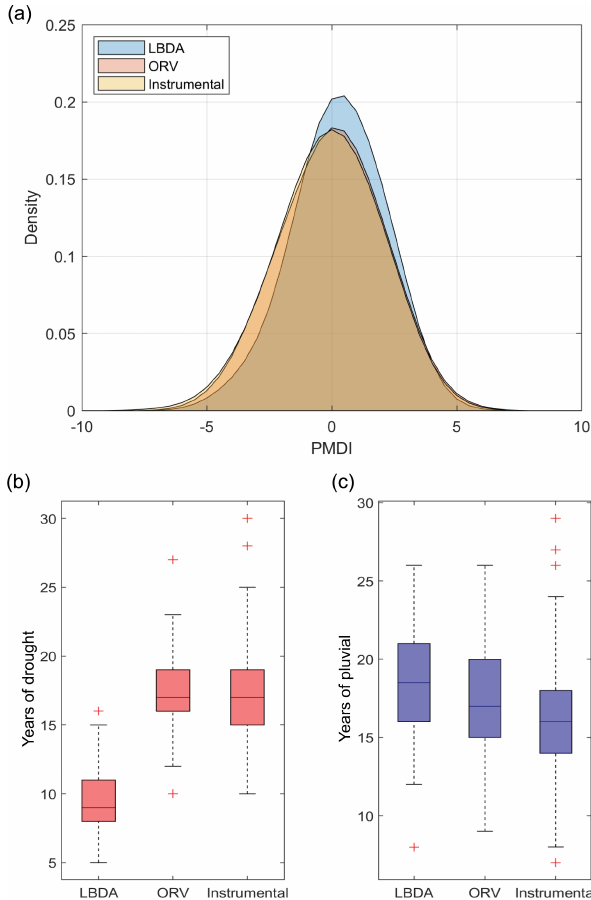
Figure 6. (a) Probability distribution functions for all gridded re- constructed PMDI values for the ORV and LBDA networks. (b) Boxplot of the number of drought (PMDI ≤ − 2 . 0) years between LBDA and ORV. (c) Boxplot of the number of pluvial (PMDI ≥ 2 . 0) years between LBDA and